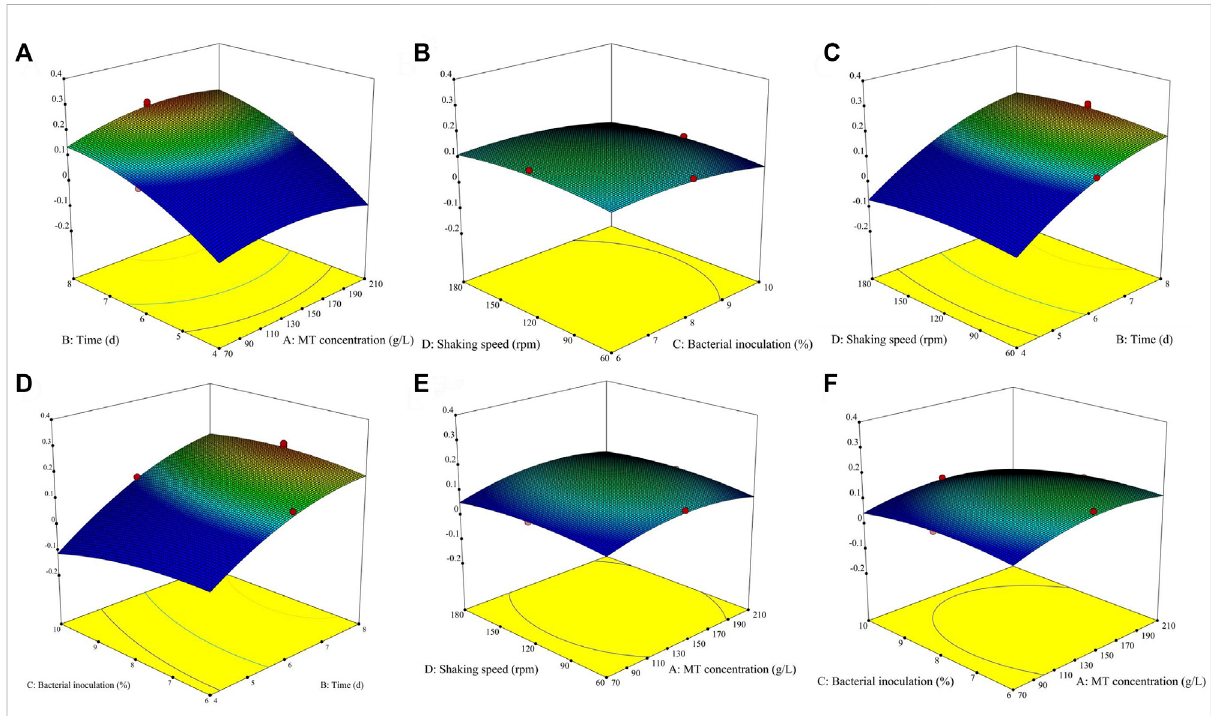
FIGURE 2 Graphical results in terms of the response surfaces of the format value of Y1 (g) of the yield of dry mycelium (Supplementary Table S2) from system optimizations. Joint graphical 3D analysis as a function of each of the variables involved [Part 1 (A – F)